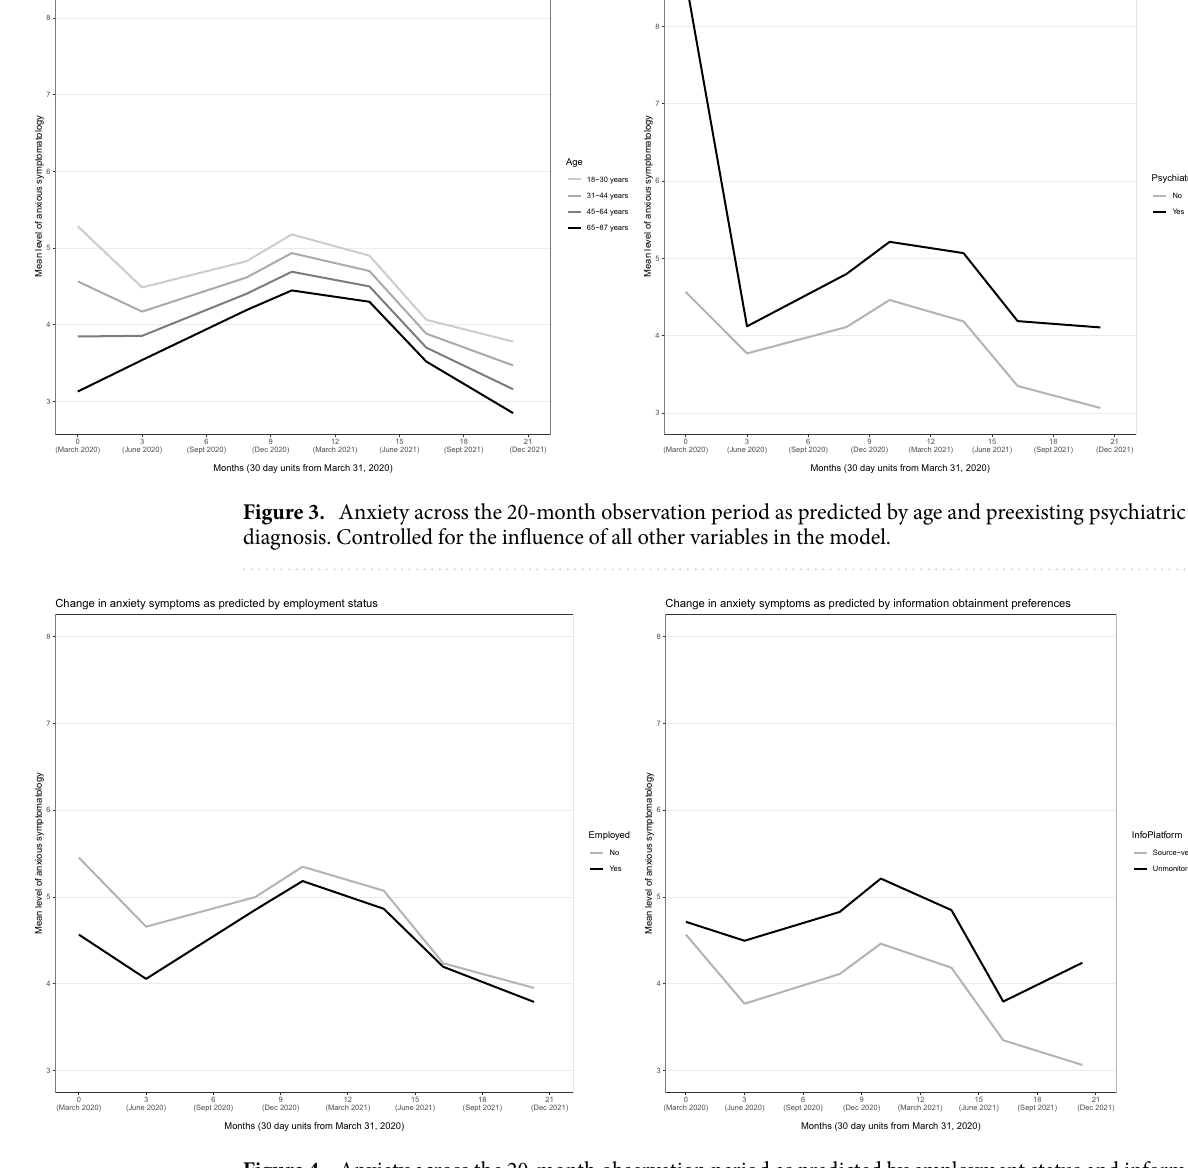
Figure 4. Anxiety across the 20-month observation period as predicted by employment status and information obtainment. Controlled for the influence of all other variables in the